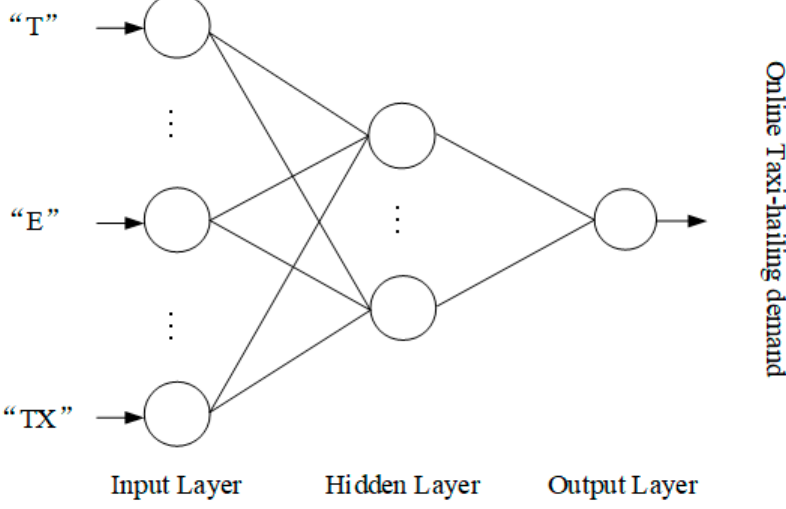
Figure 1. An instance of three-layer backpropagation neural network (BPNN).